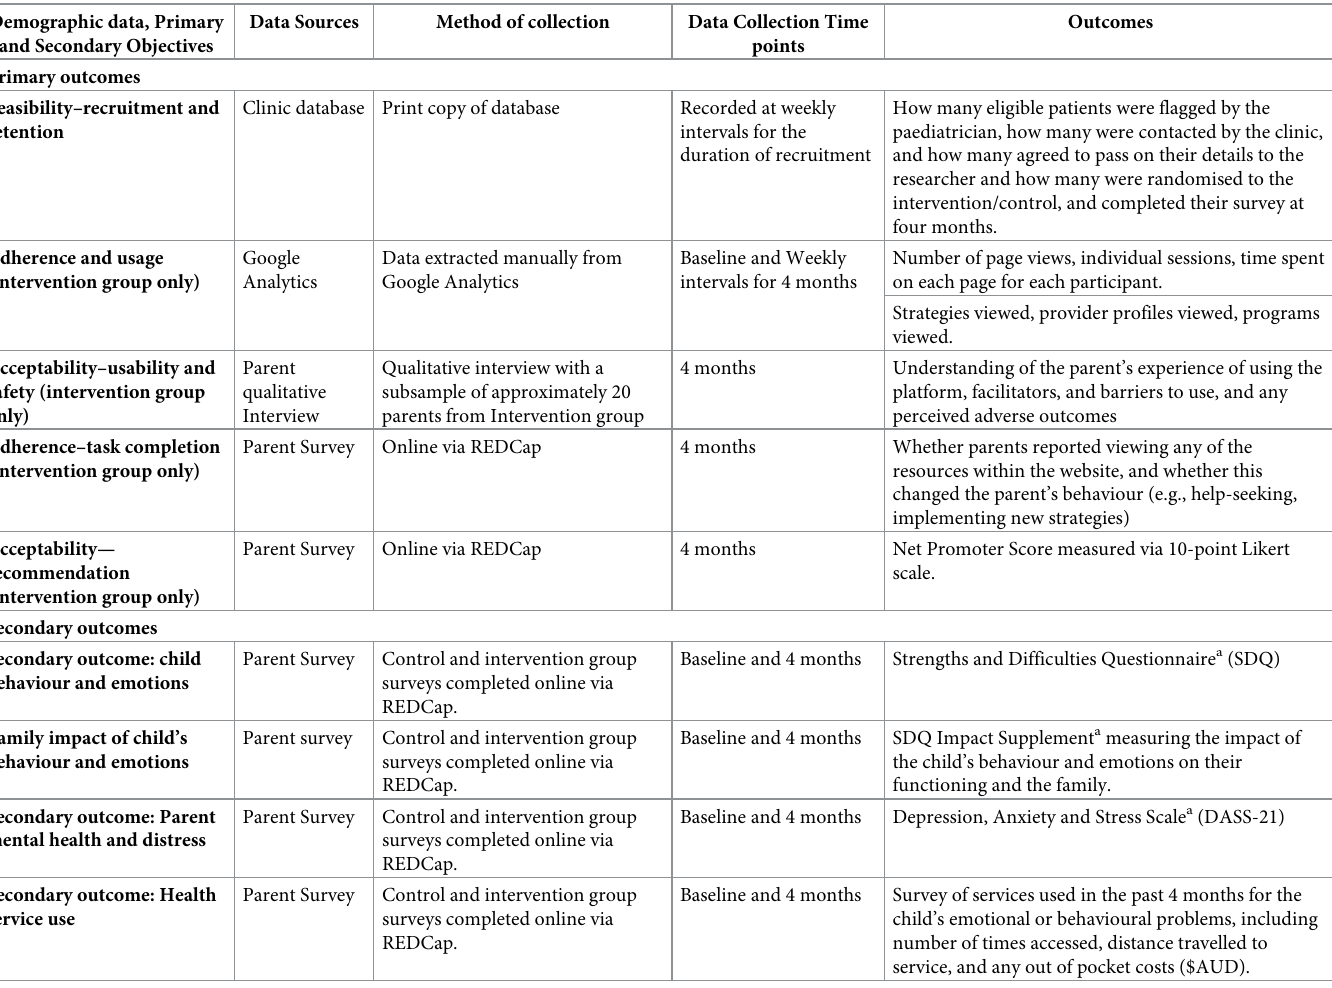
Table 1. Study objectives, data sources, data collection time points and outcome